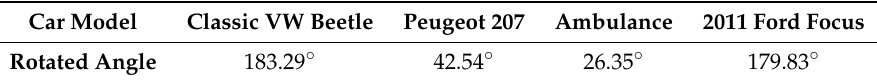
Table 6. Results of tests with real